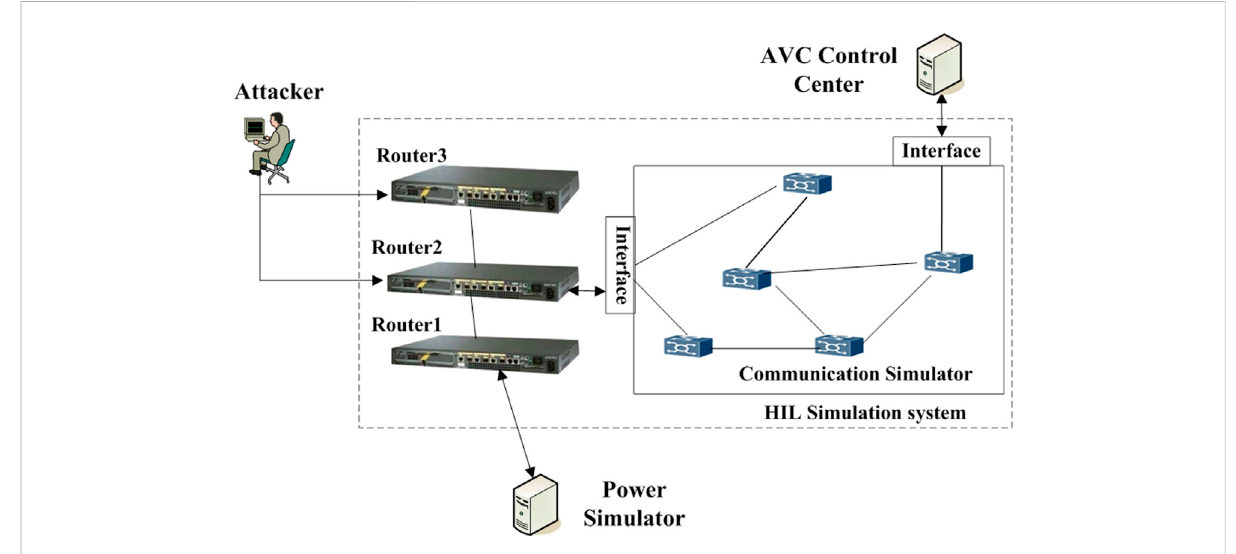
FIGURE 7 The architecture of co-simulation system for the MITM attack.